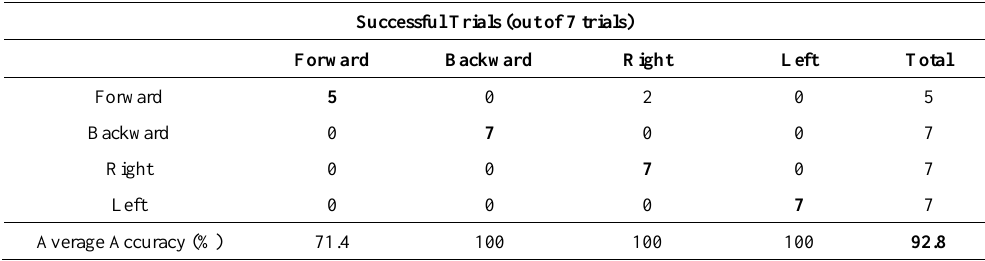
Table 3. Confusion Matrix, Second Test, Experienced